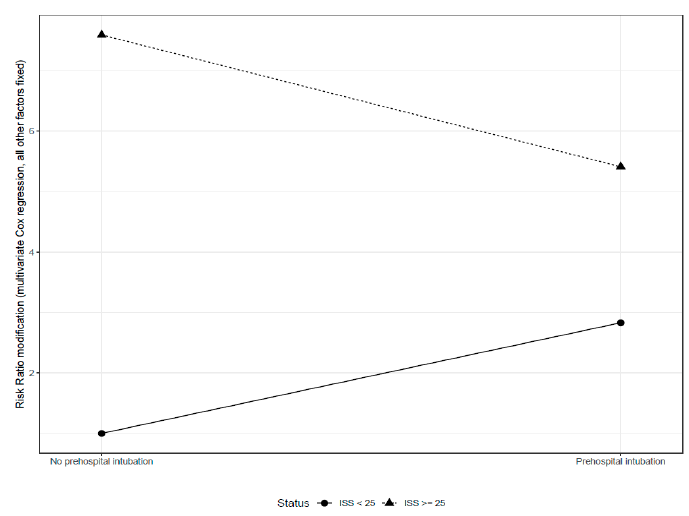
Figure 2. Interaction plot to illustrate the joint effect of pre-hospital intubation and Injury Severity Score on overall survival.